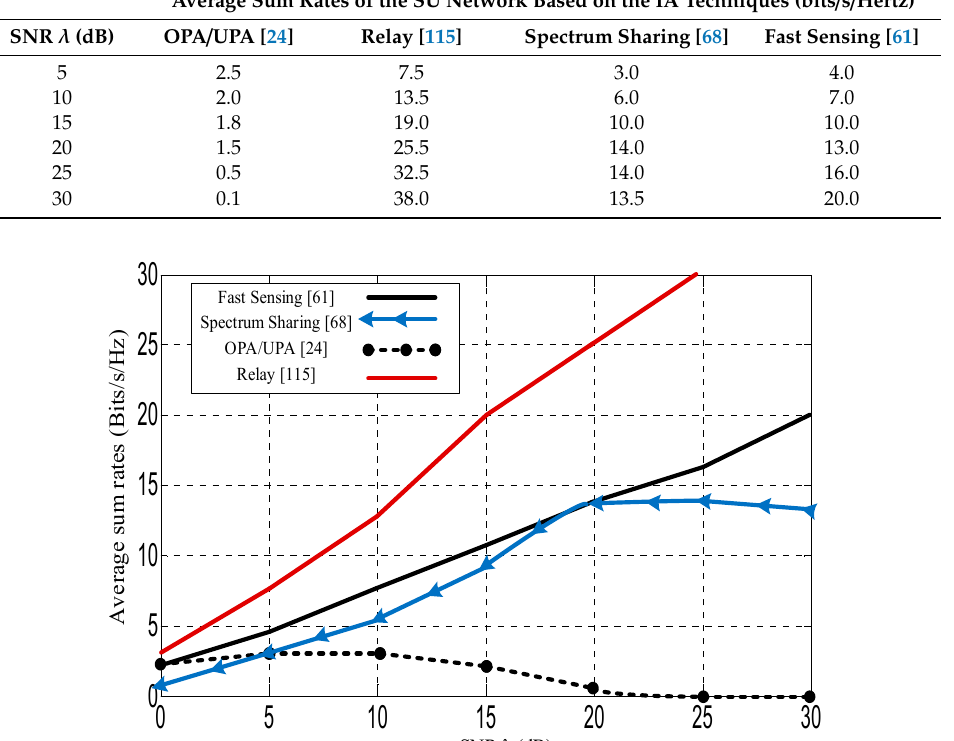
Figure 7. Average sum rates against typical SNR values for the second paradigm with SWF for the single SU MIMO link [24,61,68,115].